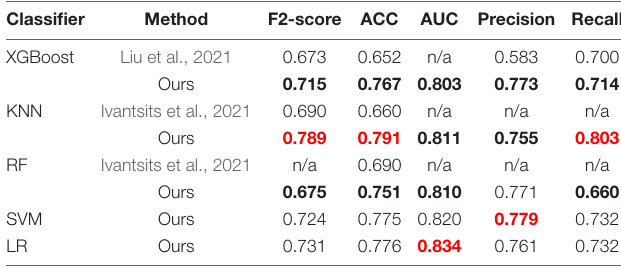
TABLE 3 | Aneurysm rupture risk estimation performance of our method and two related works based on CADA dataset. Classifier